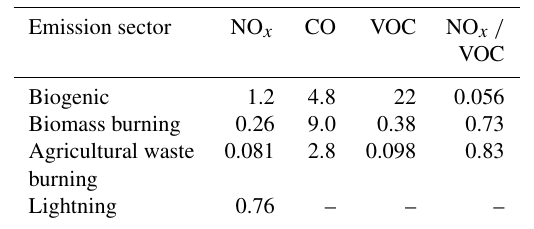
Table 6. Average (2008–2010) annual total emissions for the CM50 domain of NO x (in Tg ( NO ) a − 1 ), CO (Tg ( CO ) a − 1 ), VOC (Tg ( C ) a − 1 ), and the NO x to VOC ratio (NO x / VOC). Given are the total emissions of the emission sectors which are identical in REF and EVEU